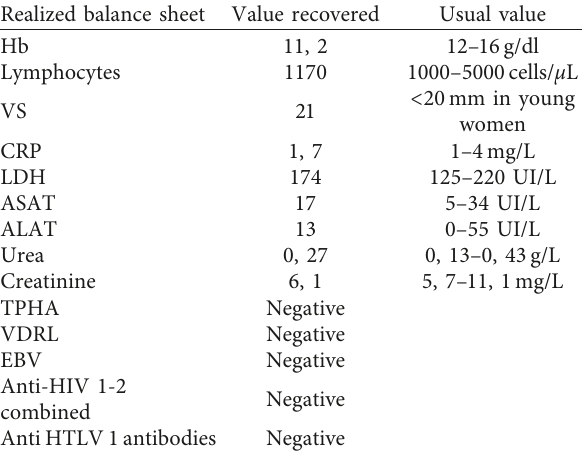
Figure 3: Immunohistochemistry had shown a lymphoid infiltrate expressing (a) CD3 +: positive, (b) CD8 +positive, and (c) KI67: proliferative index estimated at 50%. Table 1: Biological workup performed.